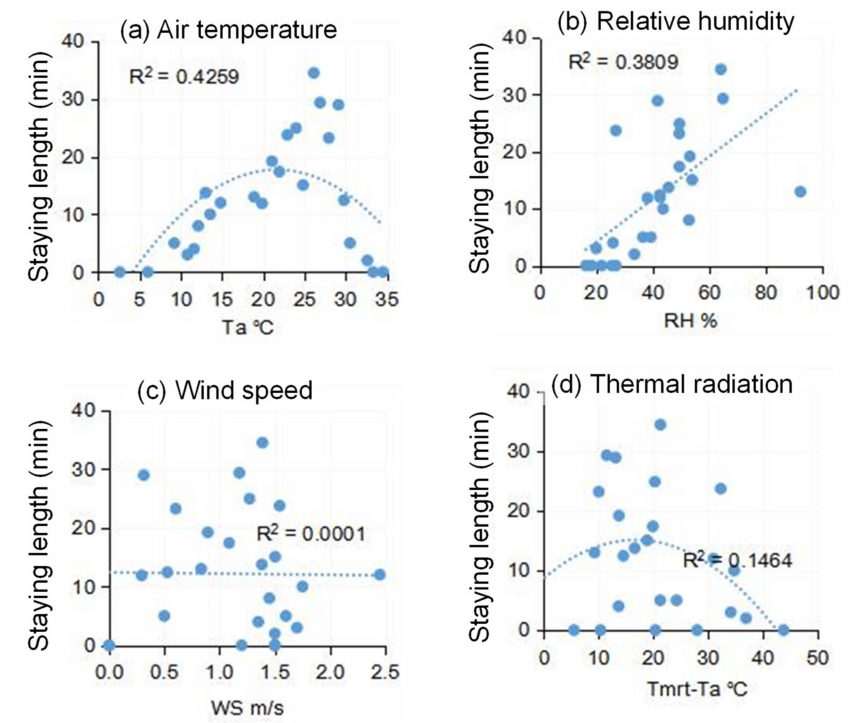
Figure 14. The relationships between staying length and T a , RH , WS , and T mrt − T a for: ( a ) Air temperature, ( b ) Relative humidity, ( c ) Wind speed, and ( d ) Thermal